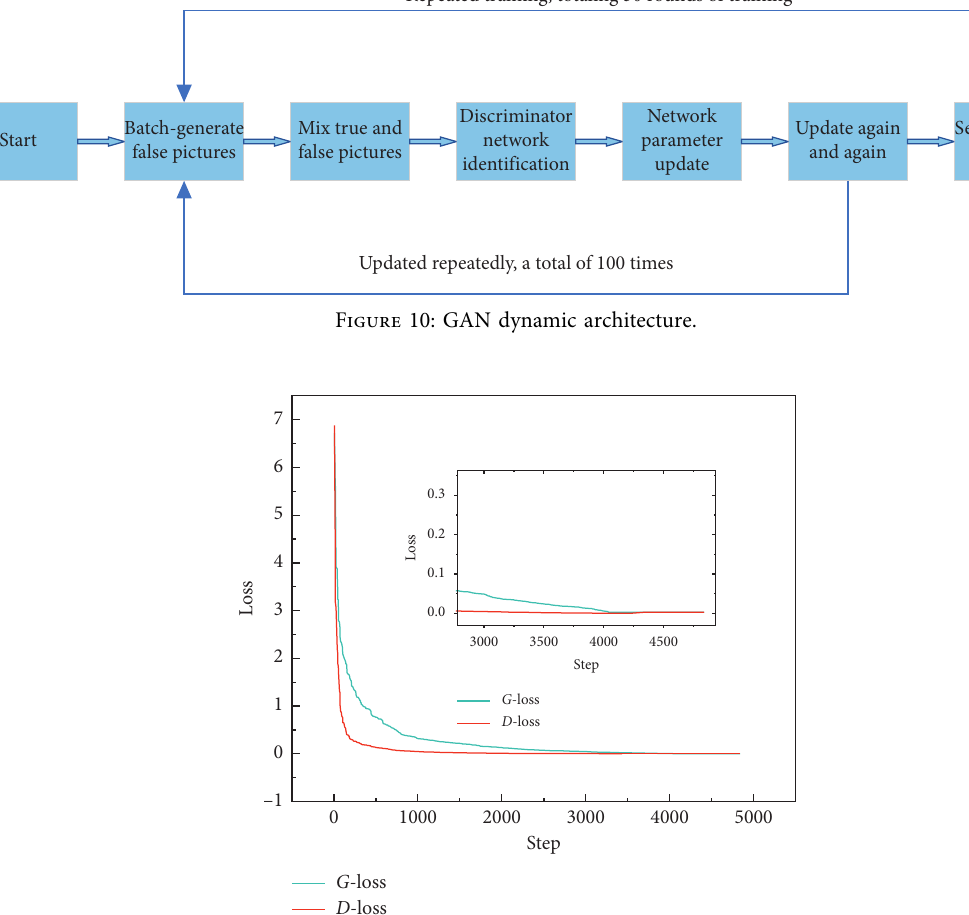
Figure 11: Loss curves of the generator and discriminator